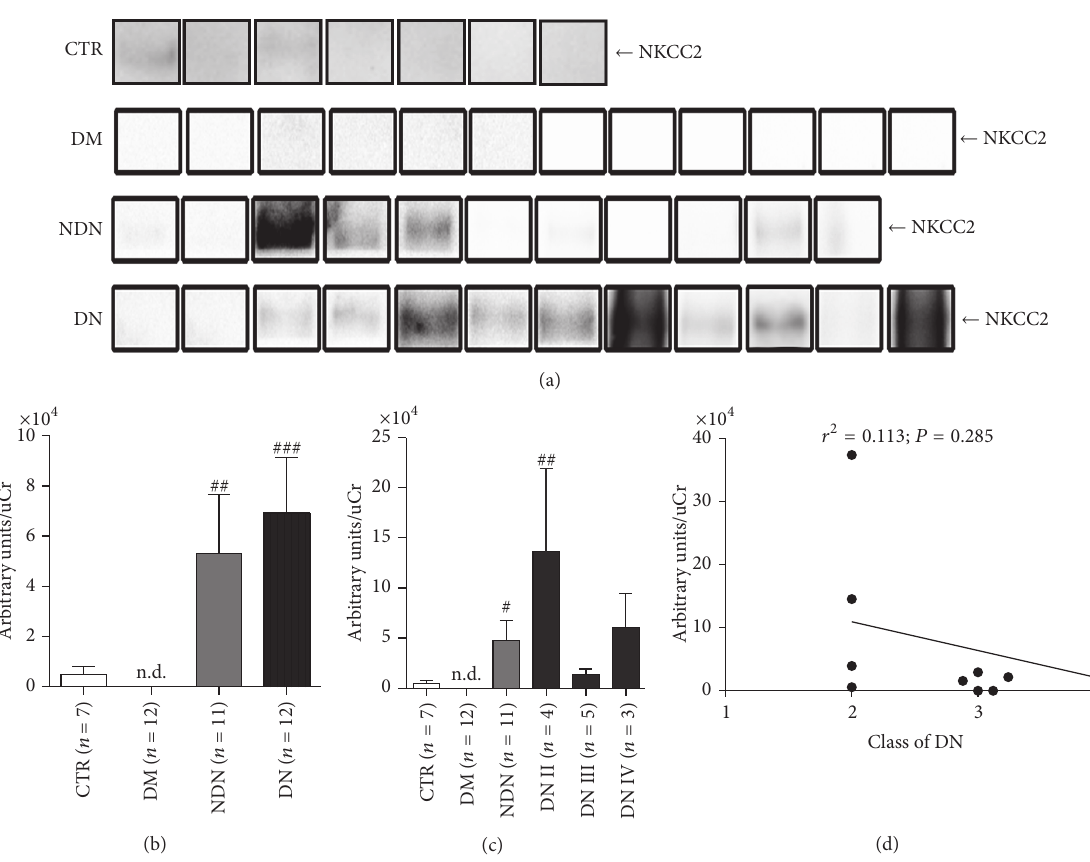
Figure 5: The urinary excretion of NKCC2 increases in both DN and NDN patients and does not correlate with the clinical severity of DN. (a) Exosomes were isolated from urine of healthy subjects (CTR, 𝑛 = 7 ), patients with DM ( 𝑛 = 12 ), patients with NDN ( 𝑛 = 11 ), and patients with DN ( 𝑛 = 12 ) using the two-step differential centrifugation method. Total exosome proteins were resolved on 10% SDS-PAGE and analyzed by Western blotting for NKCC2 abundance. (b) Densitometry analysis of the uNKCC2 band intensities was normalized for uCr and reported as means ± SEM. ### 𝑃 < 0.001 and ## 𝑃 < 0.01 versus DM, obtained by Kruskal-Wallis one-way ANOVA test. n.d.: nondetectable. (c) DN patients were grouped according to the histological changes evaluated by kidney biopsy: DN stage II ( 𝑛 = 4 ), DN stage III ( 𝑛 = 5 ), and DN stage IV ( 𝑛 = 3 ) and densitometry analysis of uNKCC2 at each stage compared to uNKCC2 in CTR and DM and NDN patients. All data are reported as mean ± SEM. ## 𝑃 < 0.01 and # 𝑃 < 0.05 versus DM, obtained by Kruskal-Wallis one-way ANOVA test. (d) Linear regression analysis of uNKCC2 abundance, as semiquantified by Western blotting, with the class of DN ( 𝑟 2 = 0.113 ; 𝑃 = 0.285